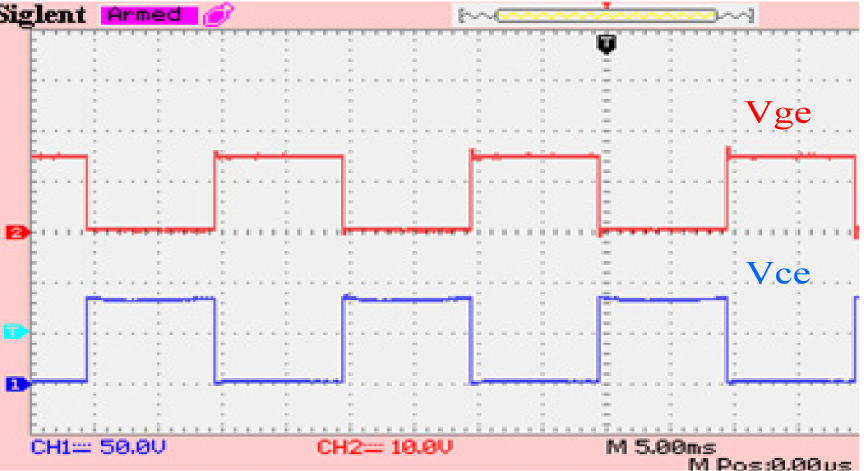
Figure 17. Gating signal VGE = 15 Volts and switch voltage VCE = 85 volts.